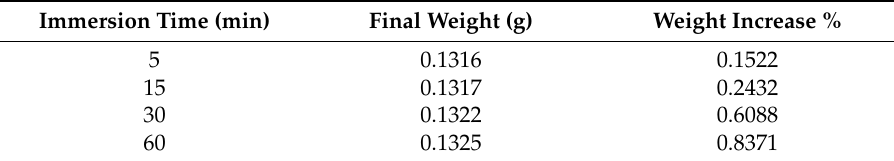
Table 2. Weight increase of the pseudoboehmite layer after increasing immersion times in water at 85 ◦ C.